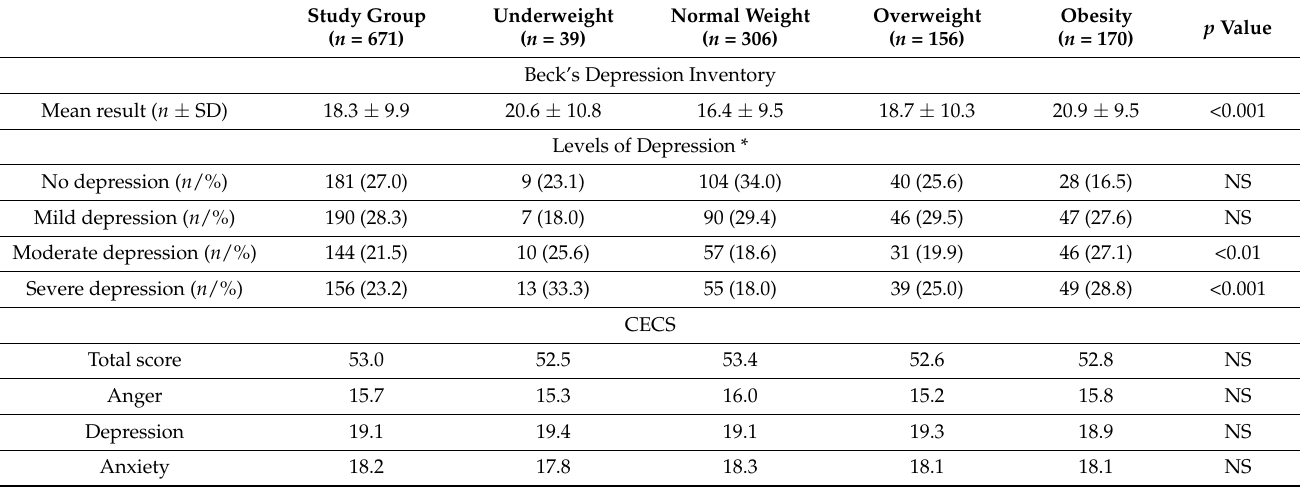
Table 2. Depression levels and emotional control according to BMI.